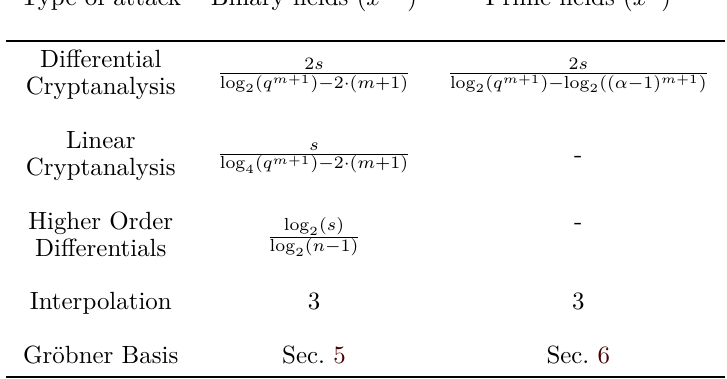
Table 1: Resistance to cryptanalytic attacks. Each row in the table denotes an attack class with each cell describing the maximal number of rounds that can be covered by this attack with respect to a security parameter s